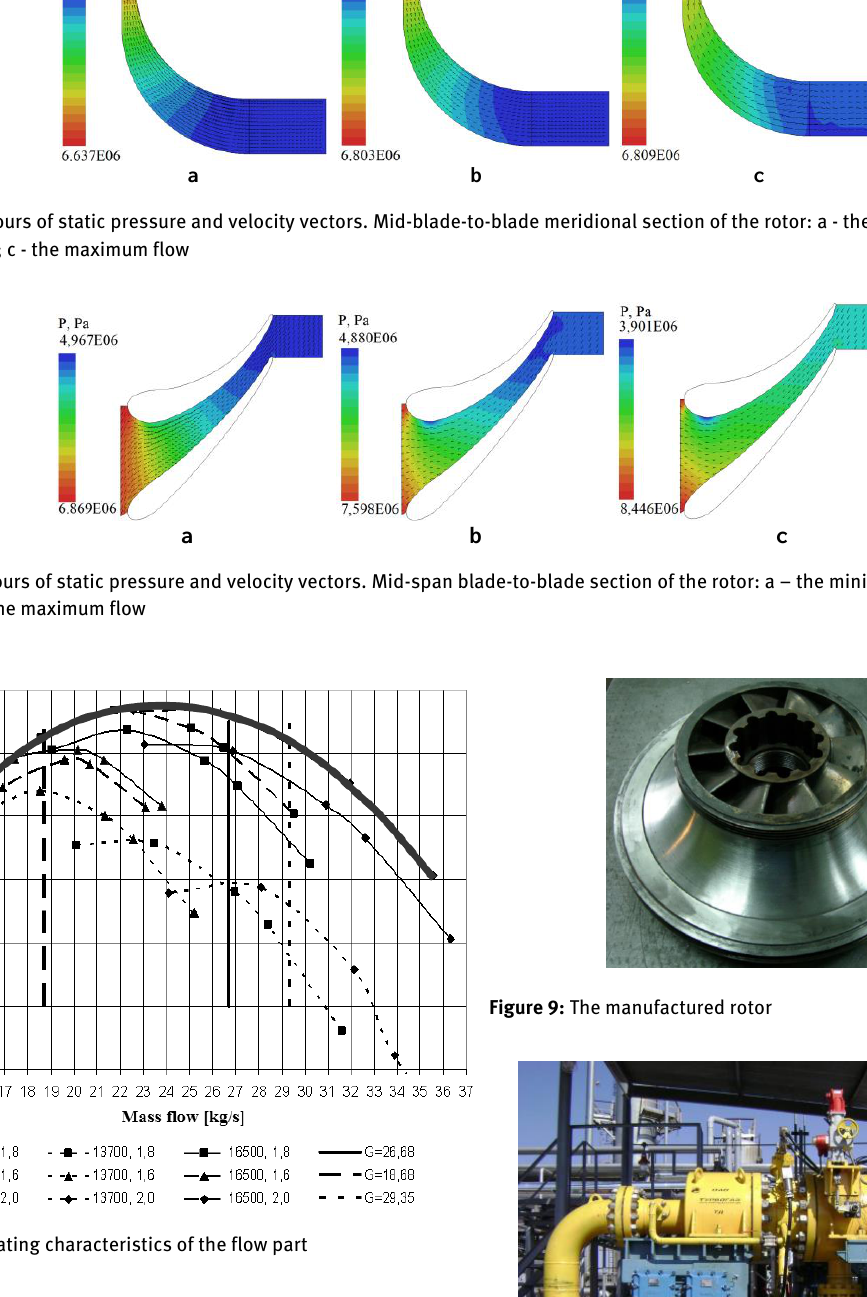
the cogeneration ORC installation, the temperature in the